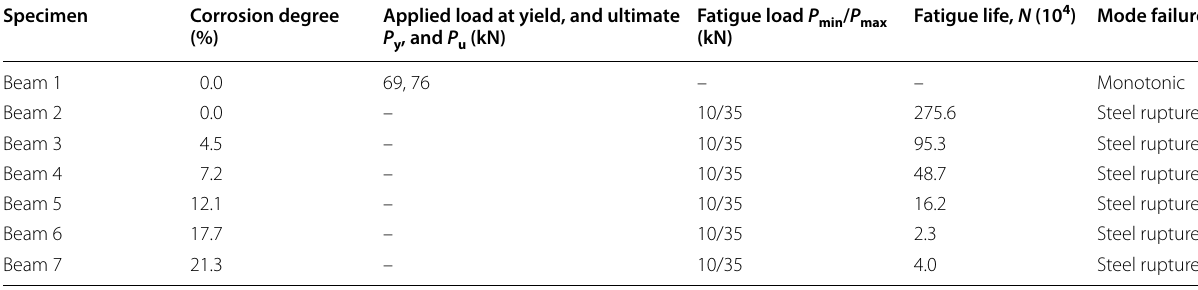
Table 1 Summary of the specimens and loading